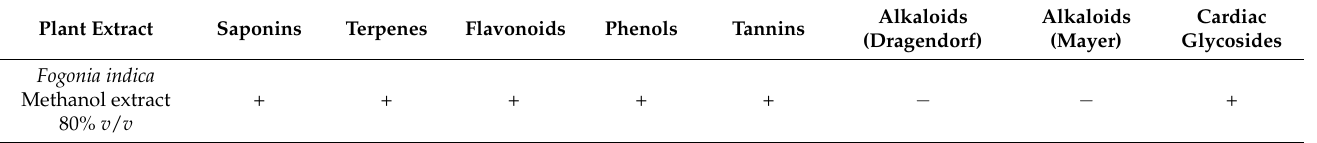
Alkaloids Alkaloids Cardiac (Dragendorf) (Mayer) Glycosides